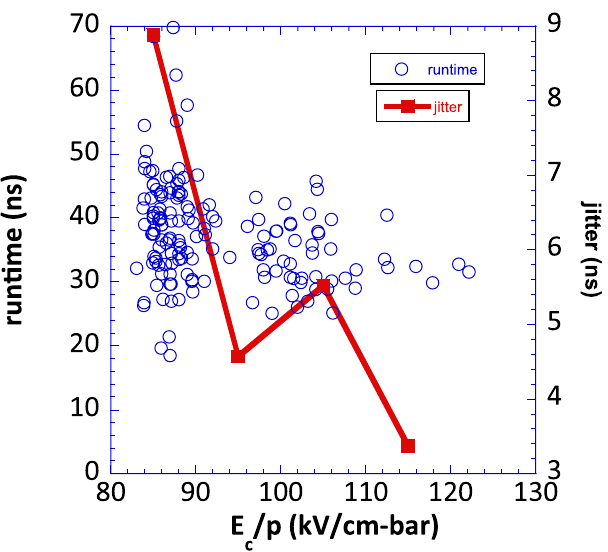
FIG. 9. (Color) Switch runtime and jitter as a function of oper- ating